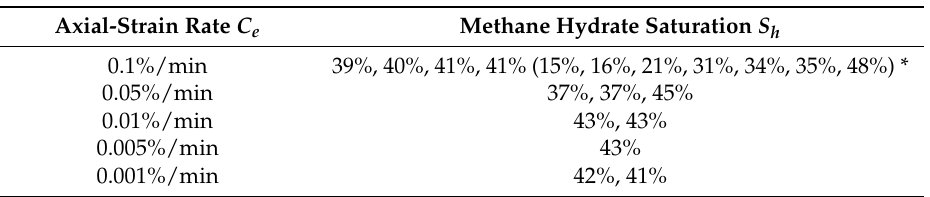
Table 1. Conditions of constant-strain-rate tests.